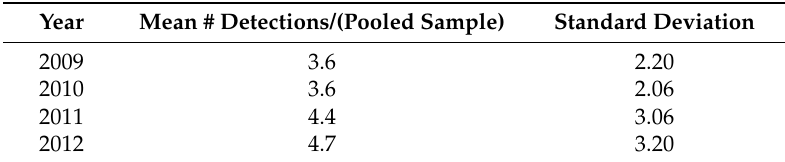
Table 6. Mean number of distinct residue detections per pollen sample by year, aggregated across all